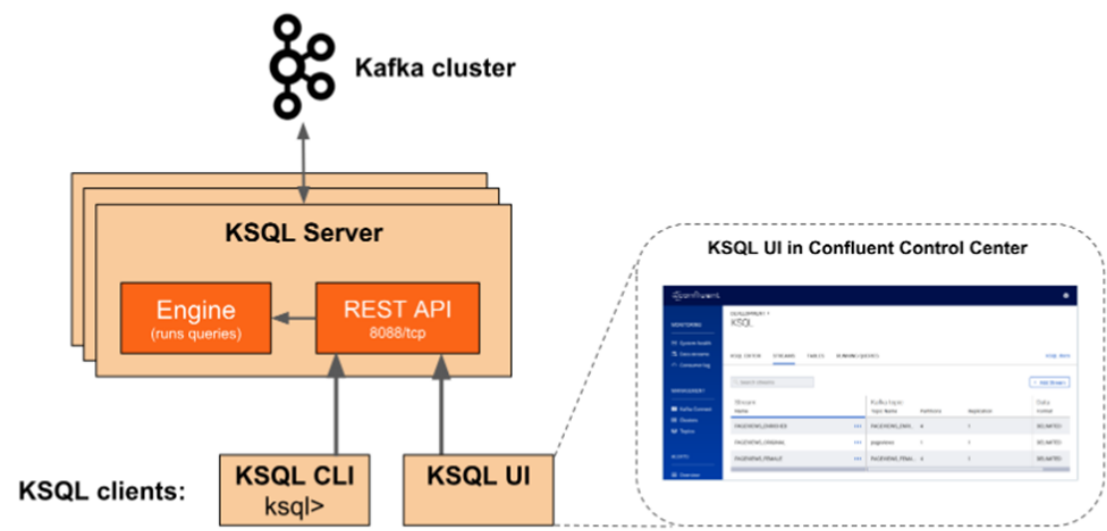
Figure 15. KSQL cluster interfacing with the Kafka broker